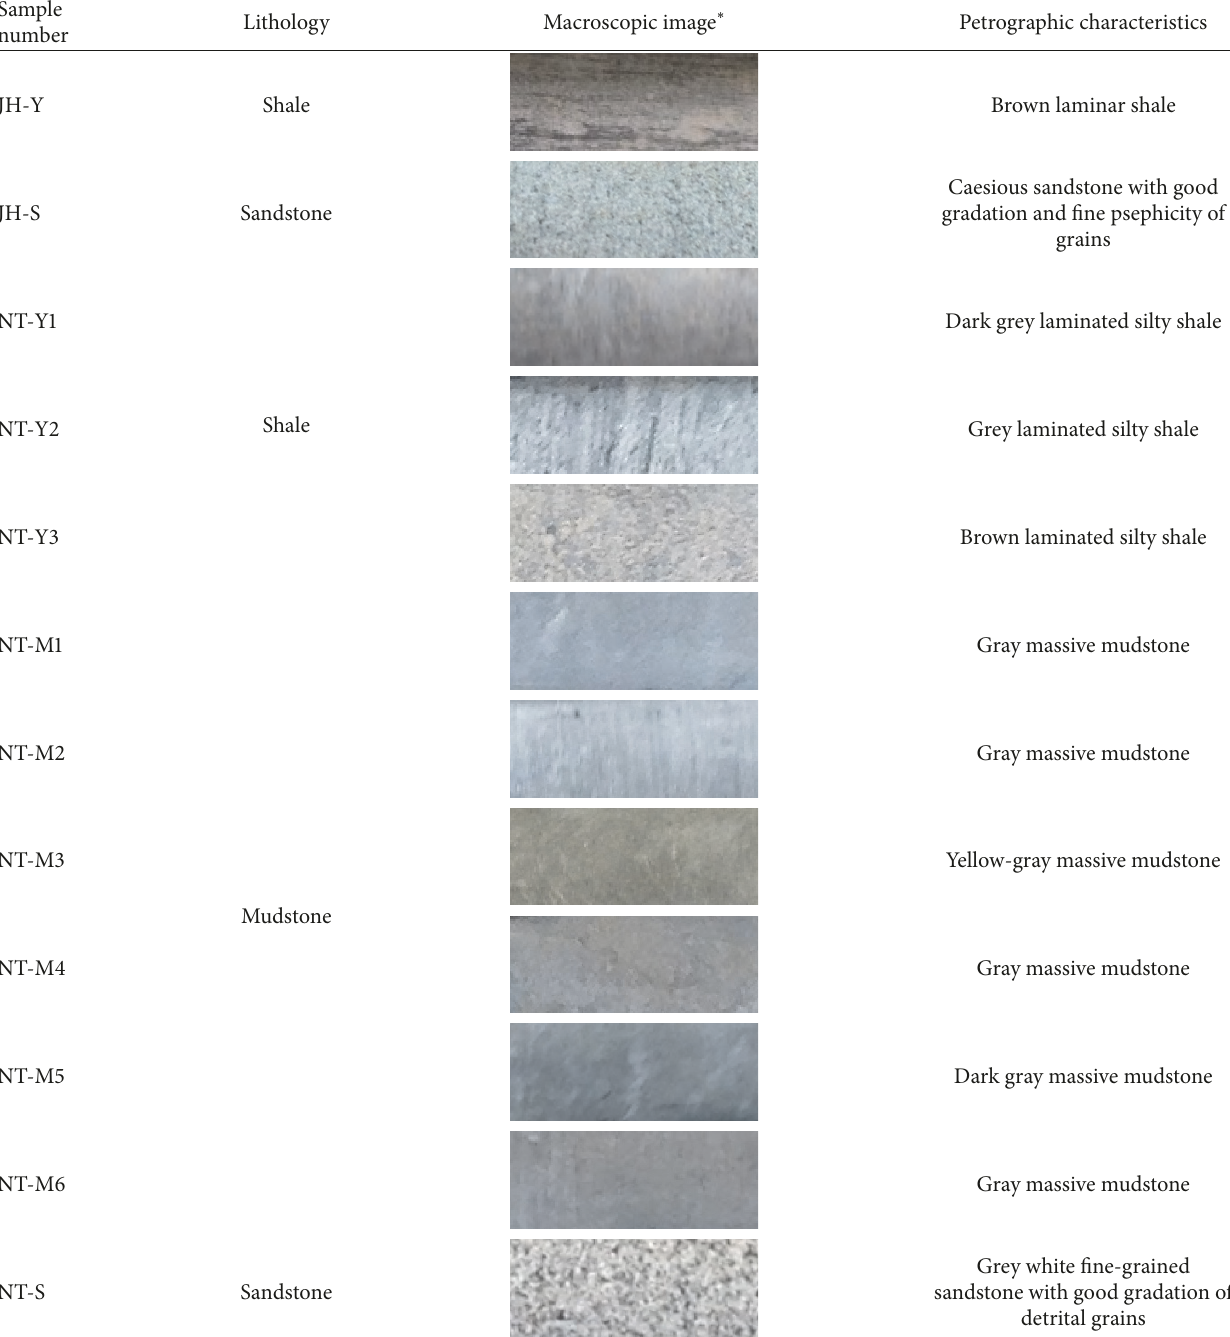
Table 1: Petrographic characteristics of the rock samples investigated in this